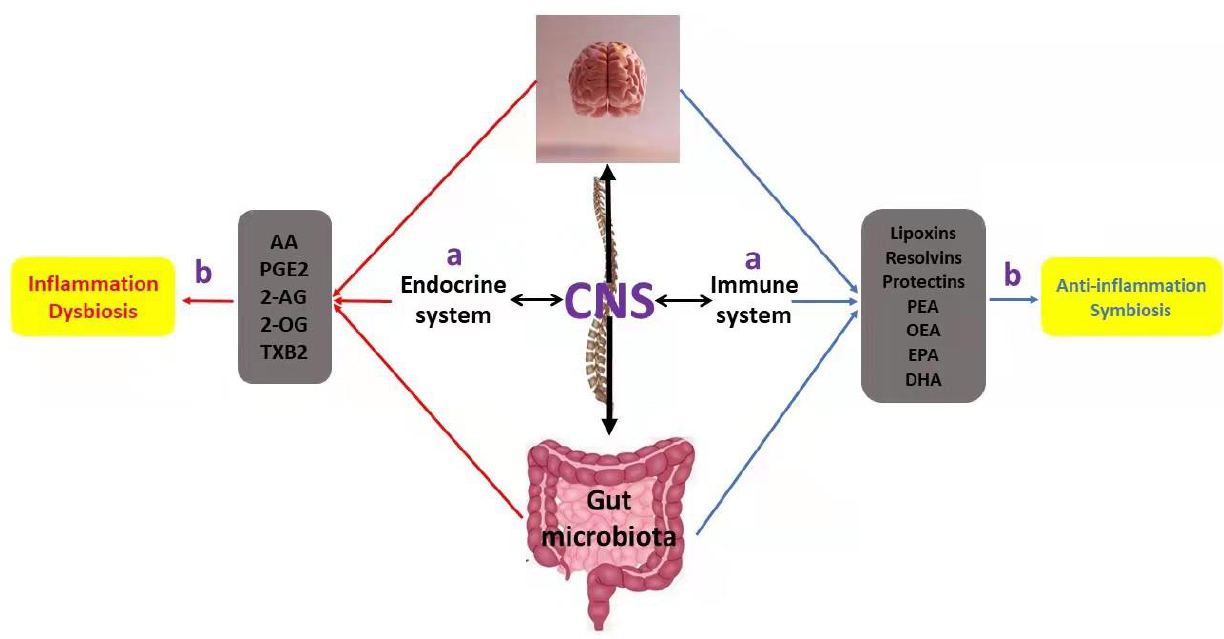
Figure 5. Schematic representation of: (a) the complex network also known as the gut–brain axis that involves different types of lipids, the gut microbiota, the central nervous system (CNS), and the endocrine and immune system, as well as (b) their impact on inflammation and gut homeostasis. Regarding bioactive lipids, red arrows and the left side indicate their pro-inflammatory activities, including dysbiosis, while blue arrows and the right side demonstrate their anti-inflammatory activities, which in turn drive a sustained net of gut